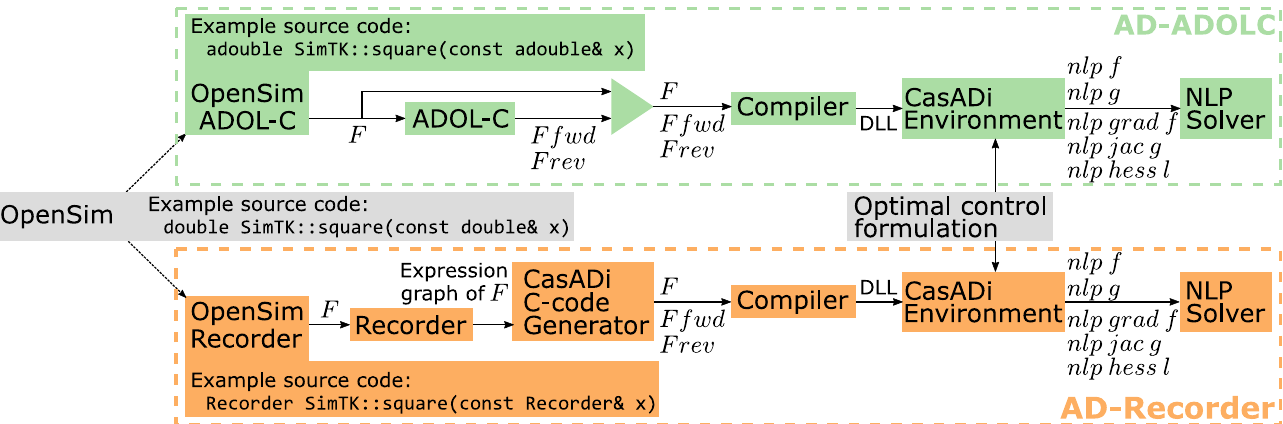
Fig 2. Flowchart depicting the optimal control framework. We developed two approaches (AD-ADOLC and AD-Recorder) to make an OpenSim function F and its forward ( F fwd ) and reverse ( F rev ) directional derivatives available within the CasADi environment for use by the NLP solver during the optimization. In the AD-ADOLC approach (top), ADOL-C’s algorithms are used in a C++ code to provide F fwd and F rev . In the AD-Recorder approach (bottom), Recorder provides the expression graph of F as MATLAB source code from which CasADi’s C-code generator generates C-code containing F , F fwd , and F rev . The AD-Recorder approach combines operator overloading, when generating the expression graph, and source code transformation, when processing the expression graph to generate C-code for F , F fwd , and F rev . In both approaches, the code comprising F , F fwd , and F rev is compiled as a Dynamic-link Library (DLL), which is imported as an external function within the CasADi environment. In our application, F represents the multi-body dynamics and is called when formulating the optimal control problem. The latter is then composed into a differentiable optimal control transcription using CasADi. During the optimization, CasADi provides the NLP solver with evaluations of the NLP objective function ( nlp f ), constraints ( nlp g ), objective function gradient ( nlp grad f ), constraint Jacobian ( nlp jac g ), and Hessian of the Lagrangian ( nlp hess l ). CasADi efficiently queries F fwd and F rev to construct the full derivative matrices.